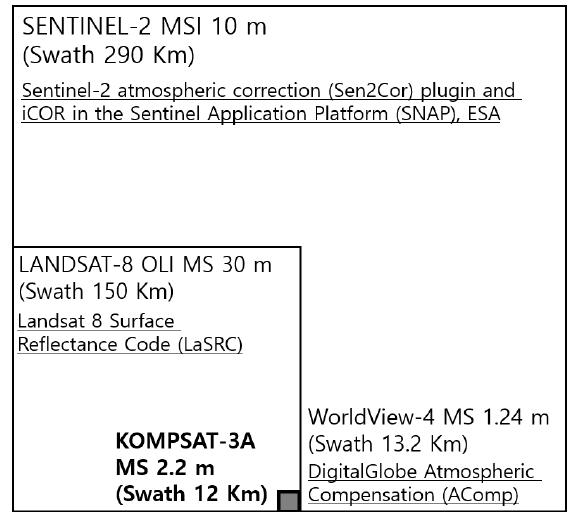
Figure 1. Optical satellite images: the spatial resolution of multispectral bands, swath width at the nadir, and atmospheric correction for producing surface reflectance.